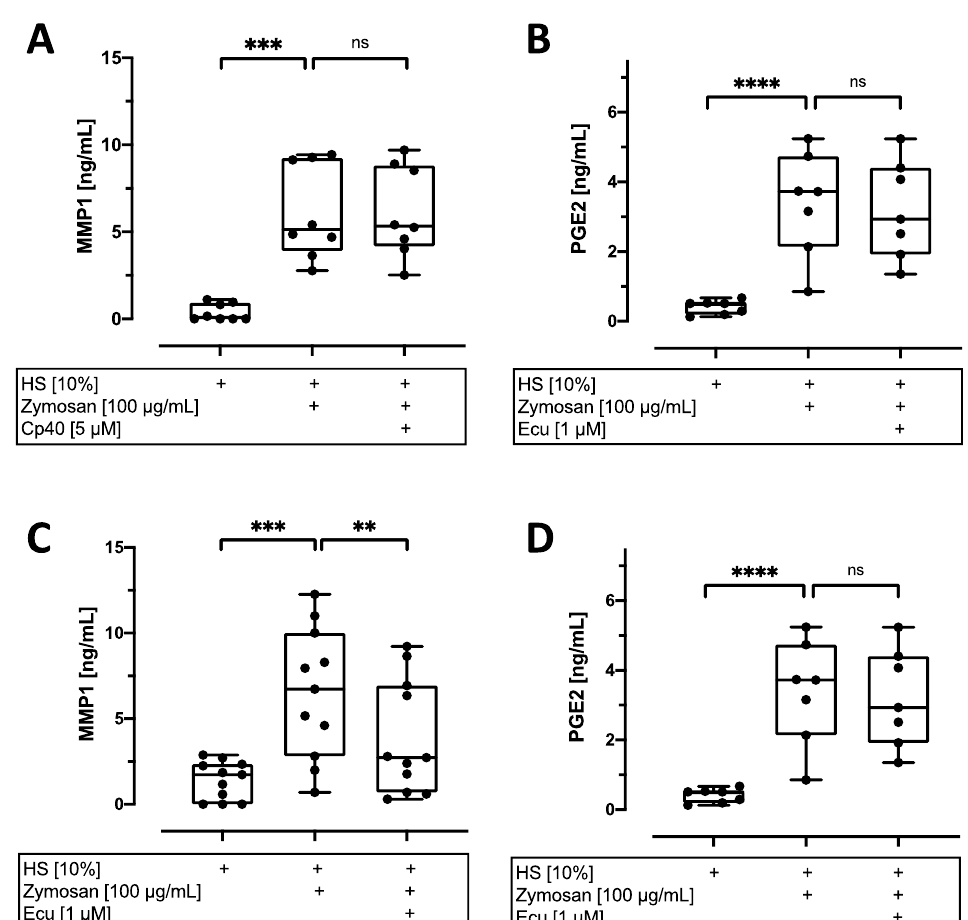
Figure 6. Quantification of MMP1 and PGE2 release from annulus fibrosus (AF) cells. Analysis of MMP1 ( A , C ) and PGE2 ( B , D ) concentrations in cell culture supernatants of AF cells after 24 h of stimulation with 10% human serum (HS) with or without zymosan (100 µg/mL) and treatment with 5 µM Cp40 ( A , B ) or 1 µM eculizumab (Ecu, C , D ). The results are presented as box-and-whisker plots with median ± interquartile ranges ( n = 8 – 11 donors per group). Significant differences are depicted as: ** p < 0.01; *** p < 0.001; **** p < 0.0001; ns: not significant. One-way ANOVA was used.